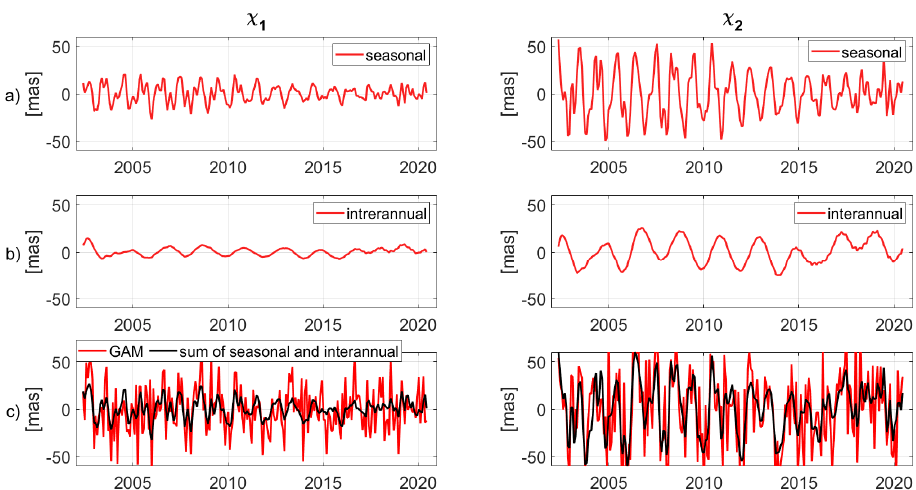
Figure 1. Monthly excitations of polar motion (GAM) per reconstruction parameters (RCs) for χ 1 and χ 2 equatorial components of ( a ) seasonal, ( b ) interannual, and ( c ) overall vs. sum of seasonal and interannual oscillations.